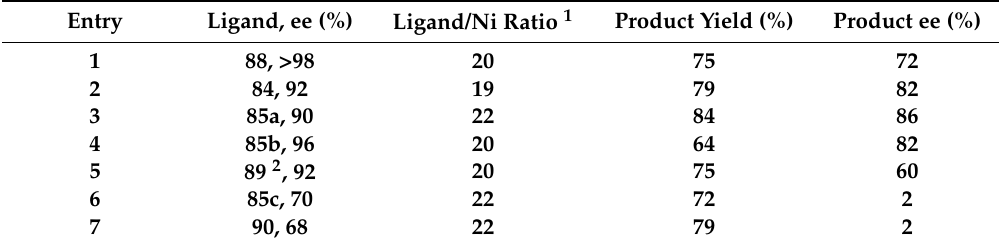
Table 4. Variation of ligand structure (in acetonitrile at − 30 ◦ C, ca. 18 h)